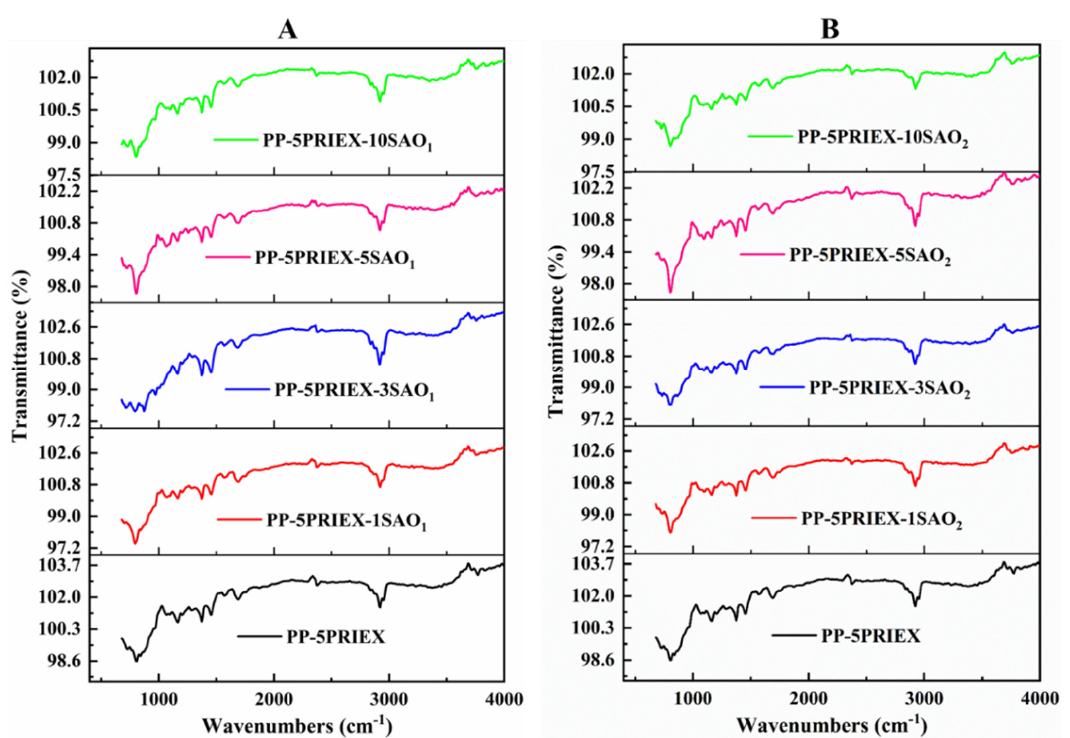
Figure 1. ATR-FTIR data of PP/PRIEX/SAO 1 ( A ) and PP/PRIEX/SAO 2 ( B ) composites. The DSC data for the SAO 1 and SAO 2 composites are presented in Tables 1 and 2, respectively. The SAO 1 and SAO 2 fillers did not affect the melting and crystalline tempera- ture (T m and T c ) of the composites, which is also evidence of the physical mixing process.